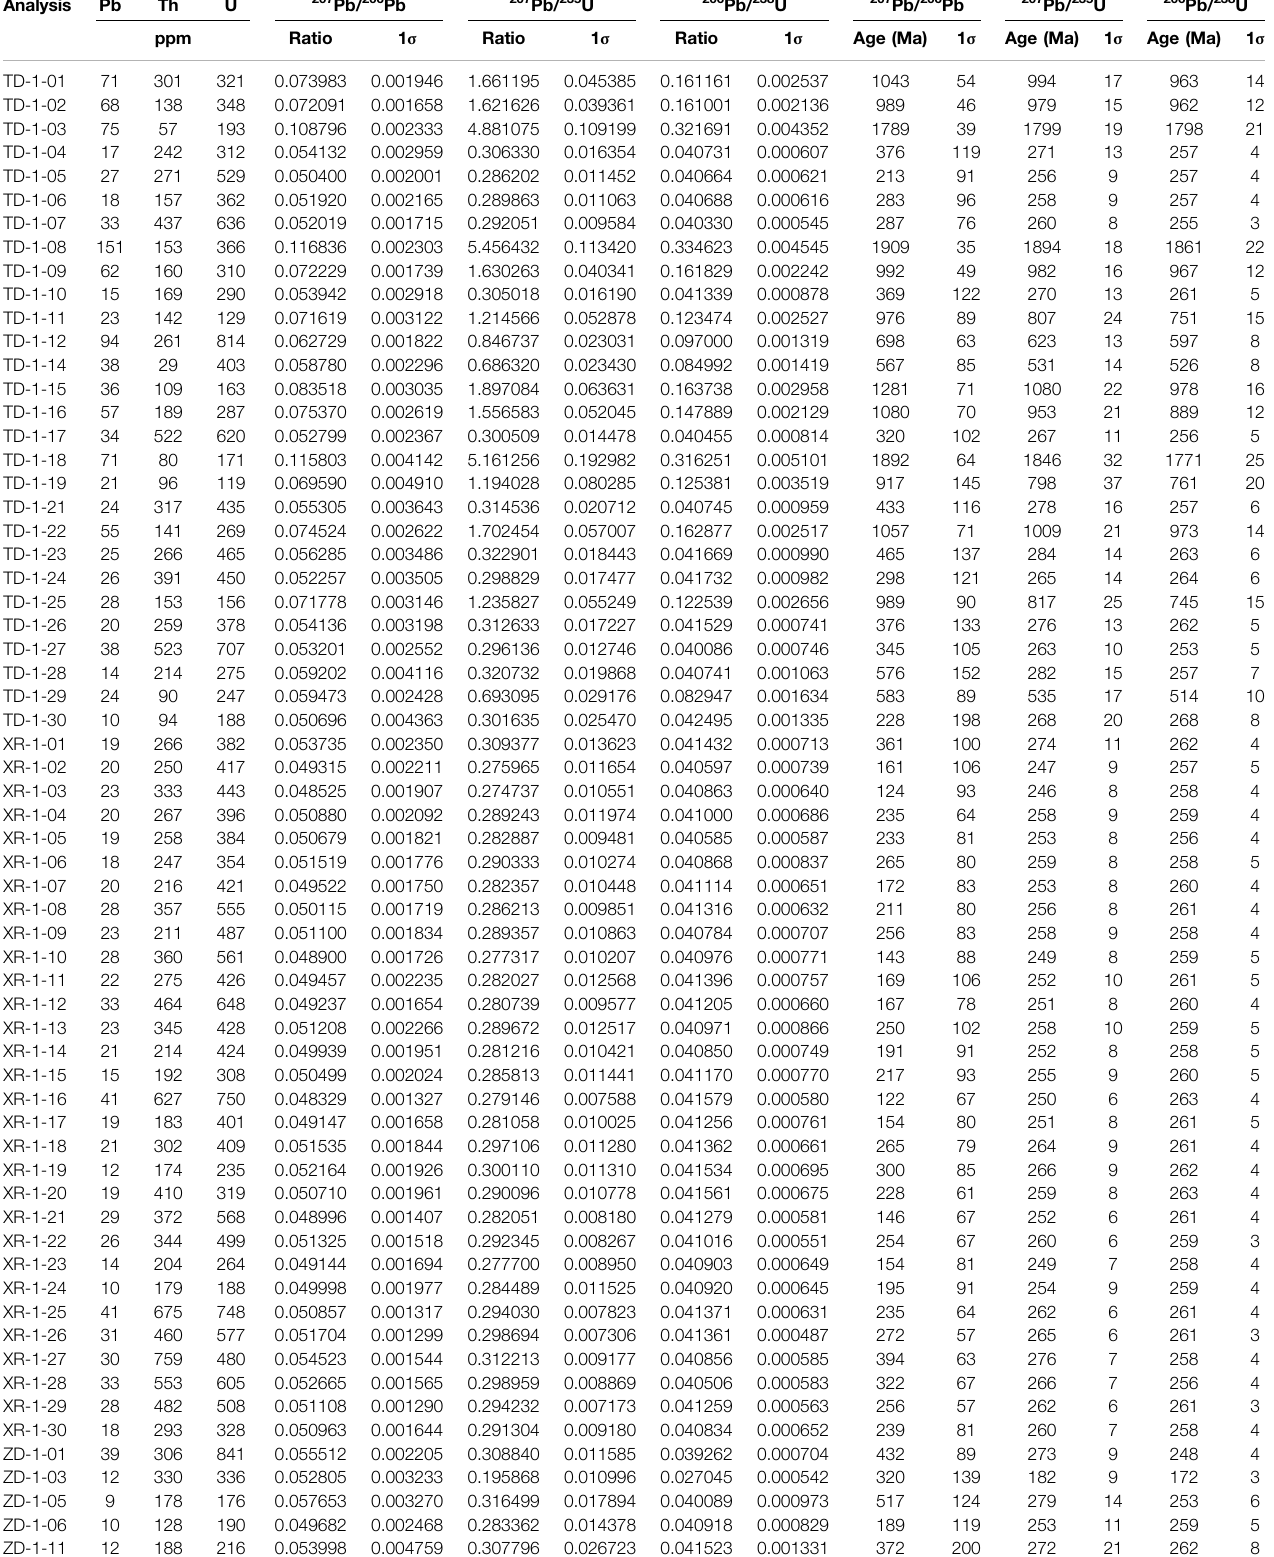
TABLE 2 | Zircon La-ICP-MS U-Pb isotopic data for the Longlin basalt samples.